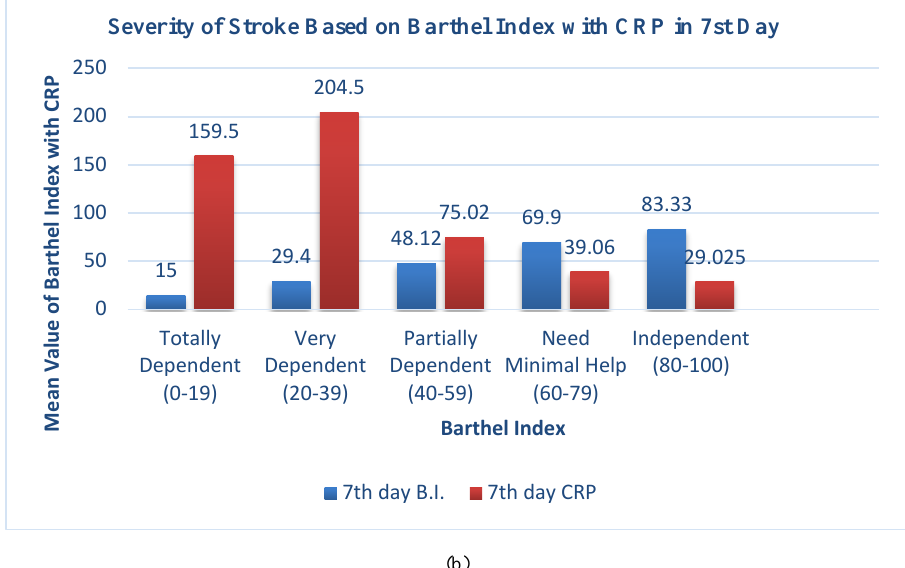
(b) Fig. 7. Severity of stroke based on Barthel index with CRP on (a) the first day, (b) the seventh